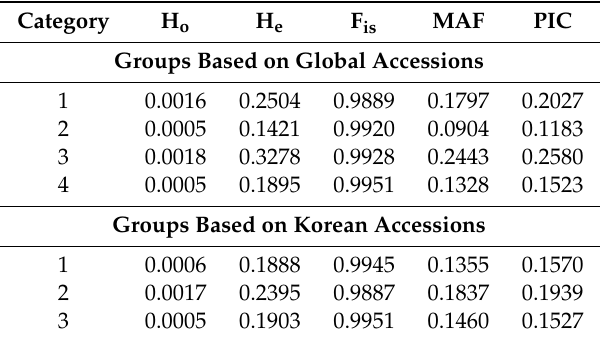
Table 2. Genetic diversity statistics for the global optimal K groups and the Korean optimal K groups.